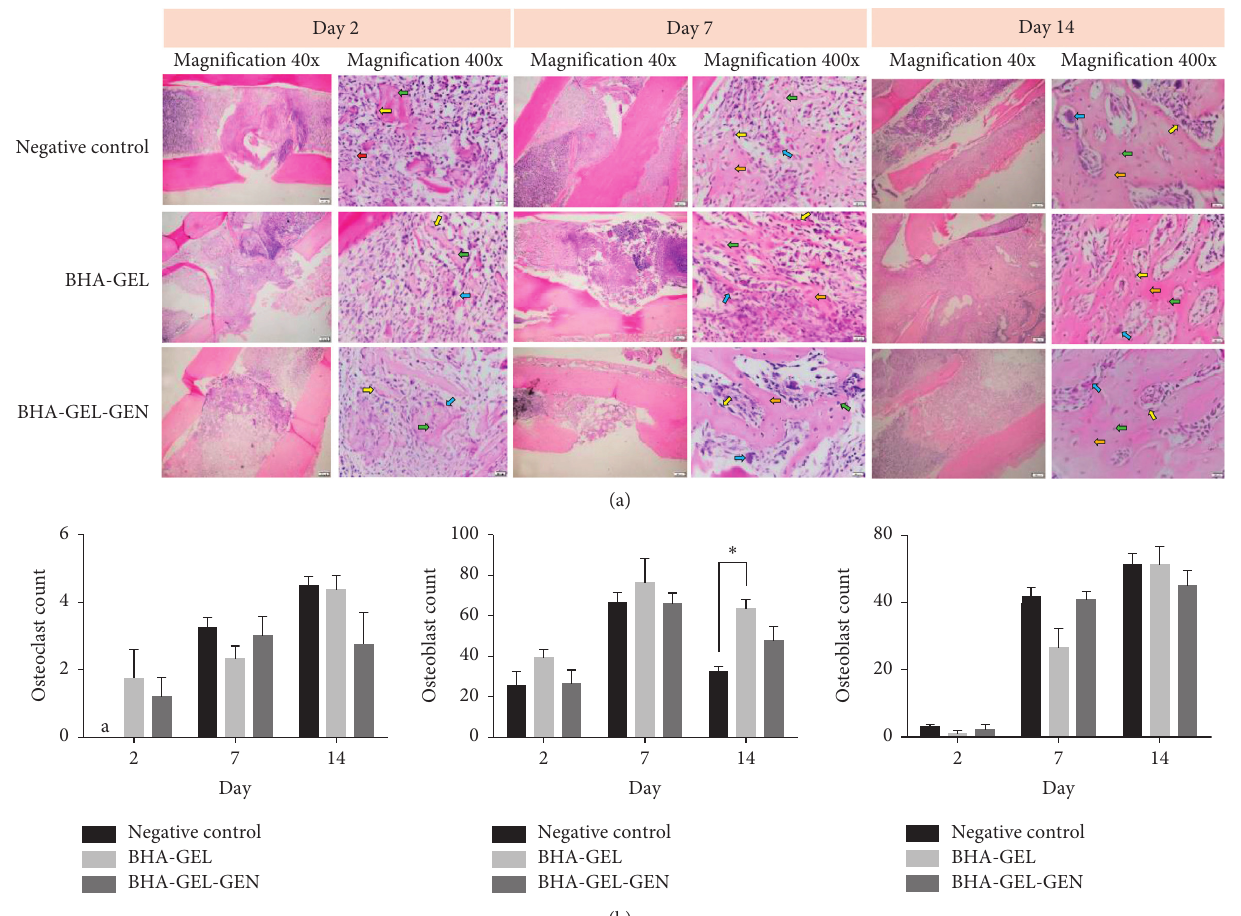
Figure 2: (a) Tangential longitudinal section of rat’s femur stained with haematoxylin and eosin. Osteoclasts (blue arrows), osteoblasts (yellow arrows), osteocytes (green arrows), osteoprogenitor cells (red arrows), and cartilage (orange arrows). (b) The number of osteoclasts, osteoblasts, and osteocytes in each group. Each bar represents the mean cell count ± SEM of the two rats observed in at least two different visual fields. ∗ p < 0 . 01 with Kruskal Wallis. a No cells